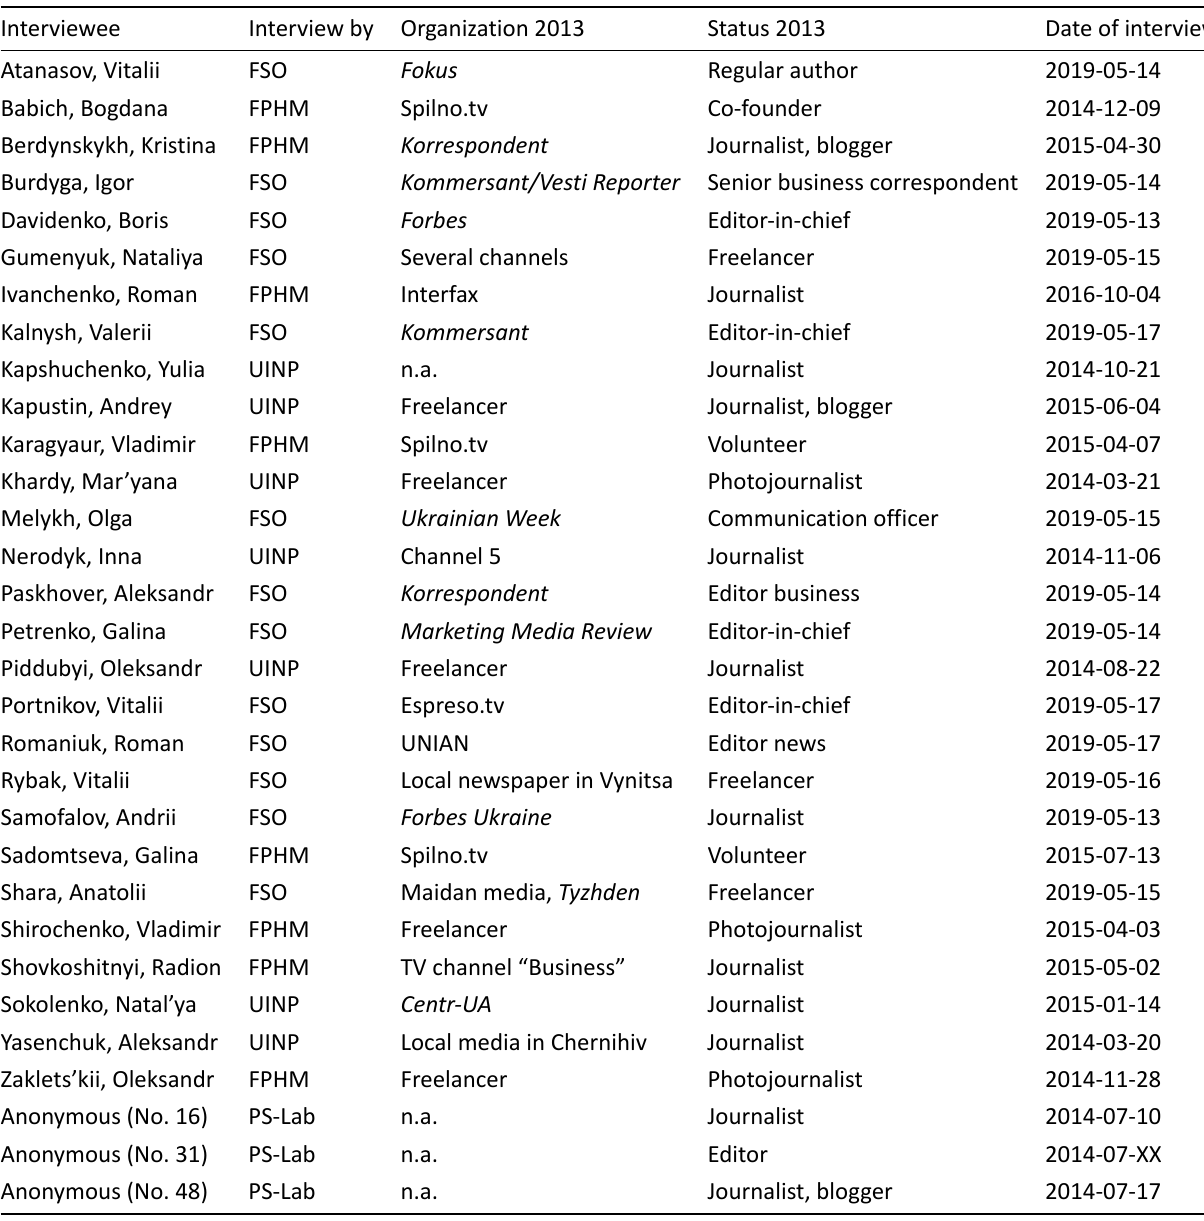
Table 1. List of interview